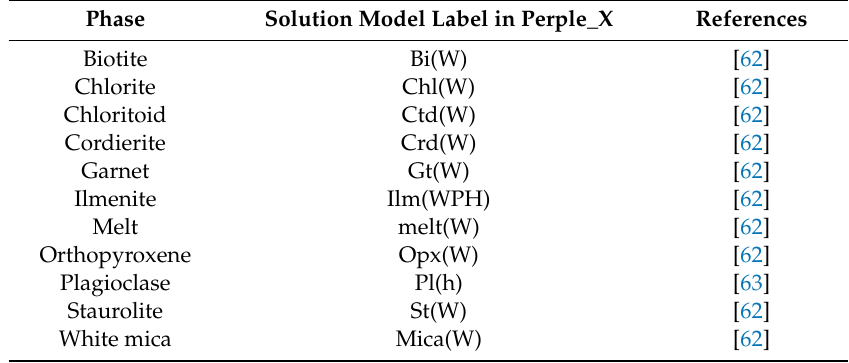
Table 1. Solution models used for the pseudo-sections (See Figure 15a). See Perple_X documentation (http: // www.perplex.ethz.ch) for detailed